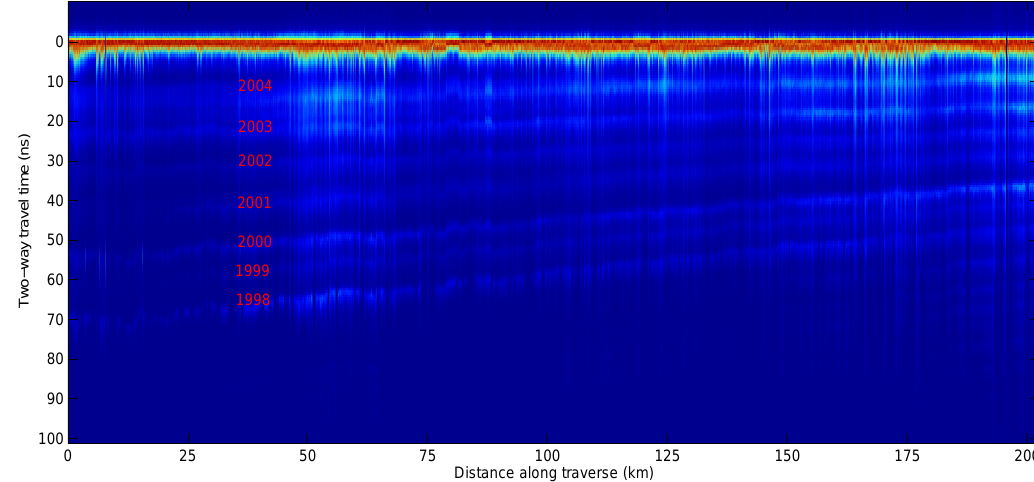
Fig. 2. ASIRAS profiles showing the waveforms recorded along a 200km transect (Fig. 1) over the dry snow zone of the ice sheet. The waveforms are centred at the location estimated to be the surface reflection which can be clearly identified. Weaker reflections from the snowpack volume are related to annual horizons. The accumulation from each “mass balance” year is given representing the time between each end-of-summer horizon (prior to the formation of autumn hoar). Table 2. Mean annual accumulation rates for the years 1998–2003. Values are in m.w.e. Decrease in accumulation Linear regression correlation accumulation